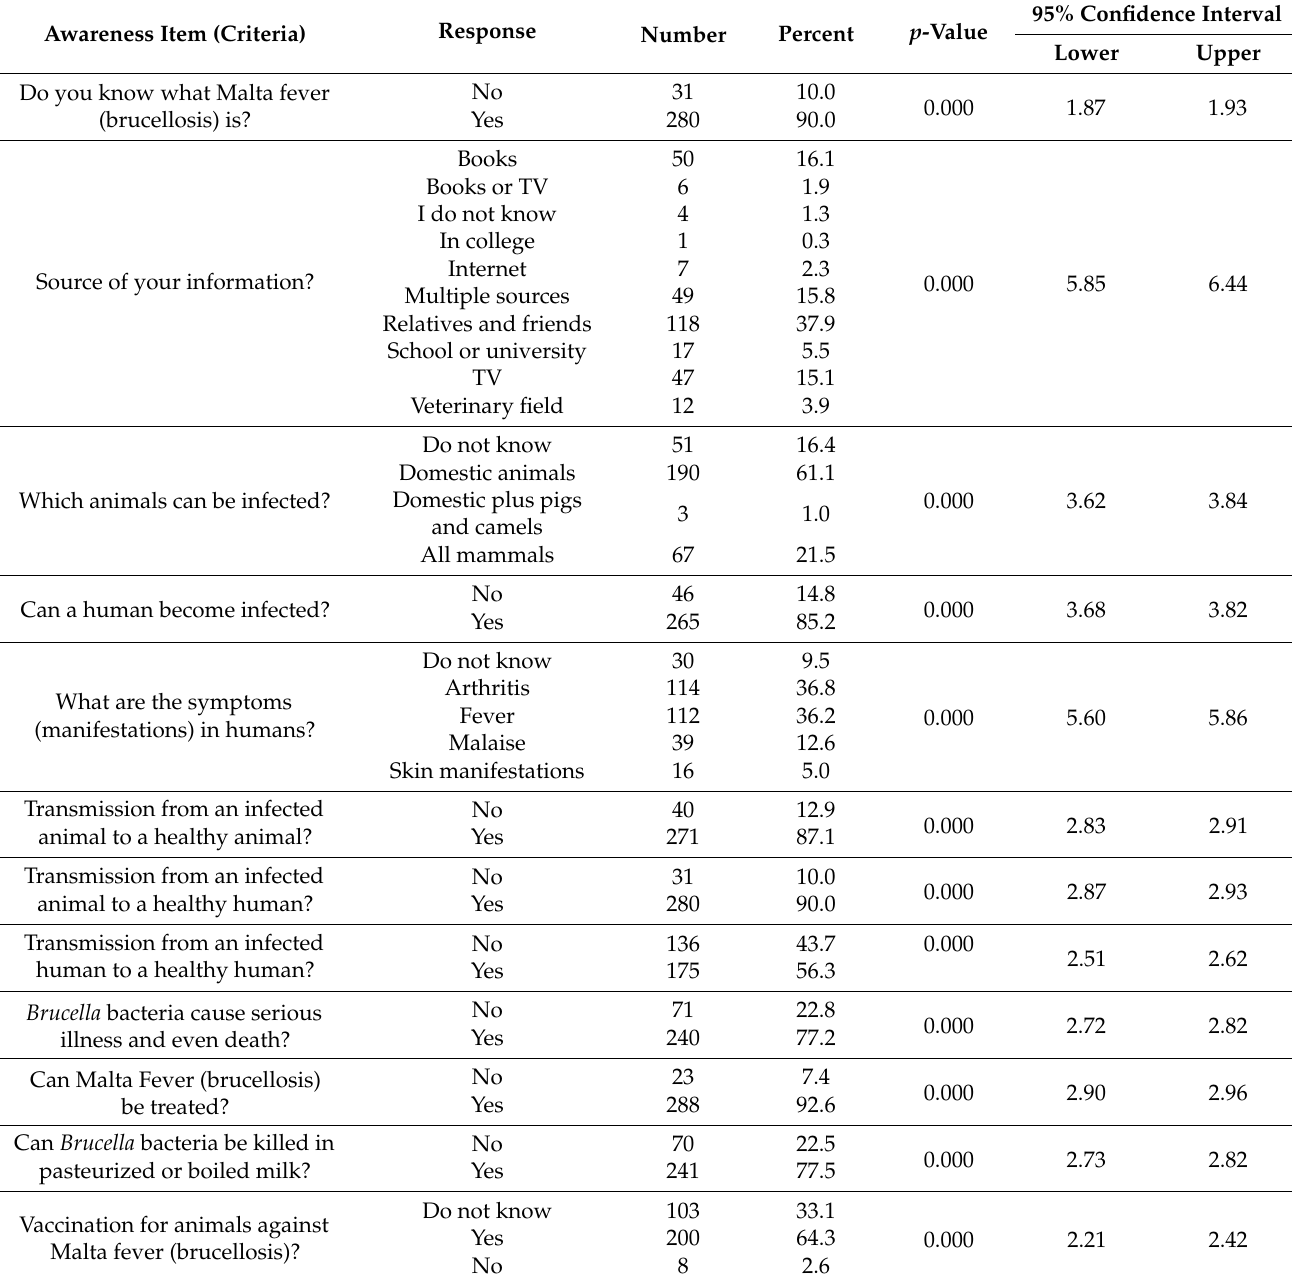
Table 2. Items of awareness regarding brucellosis among parents in the Aseer region, southwestern Saudi Arabia. Awareness Item